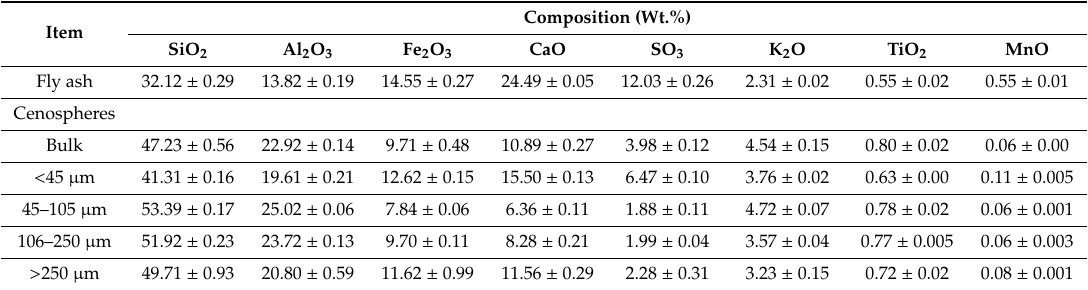
Table 5. Chemical composition of the collected cenospheres classified in di ff erent size ranges of < 45, 45–105, 106–250, > 250 µ